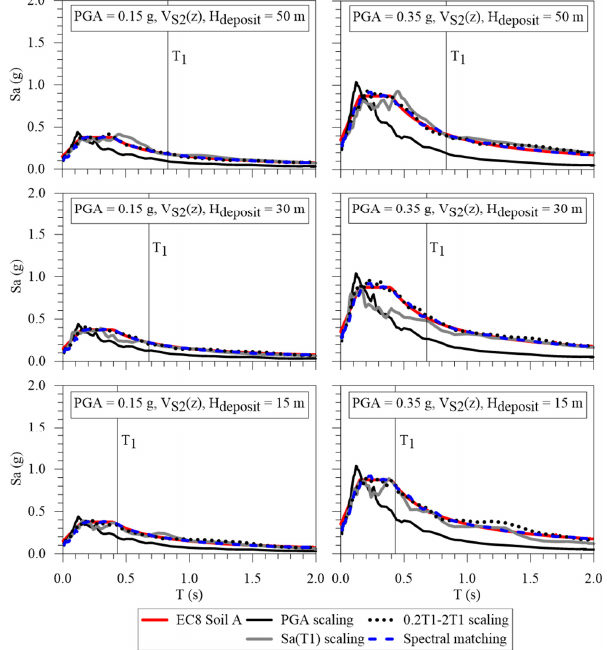
Figure 4. Mean response spectra of the input motions selected according to 4 different selection strategies for PGA equal to 0.15 g and 0.35 g, and V S2 (z) profile. The response spectra going from the first line to the bottom one refers to a H deposit equal to 50, 30, and 15 m, respectively.